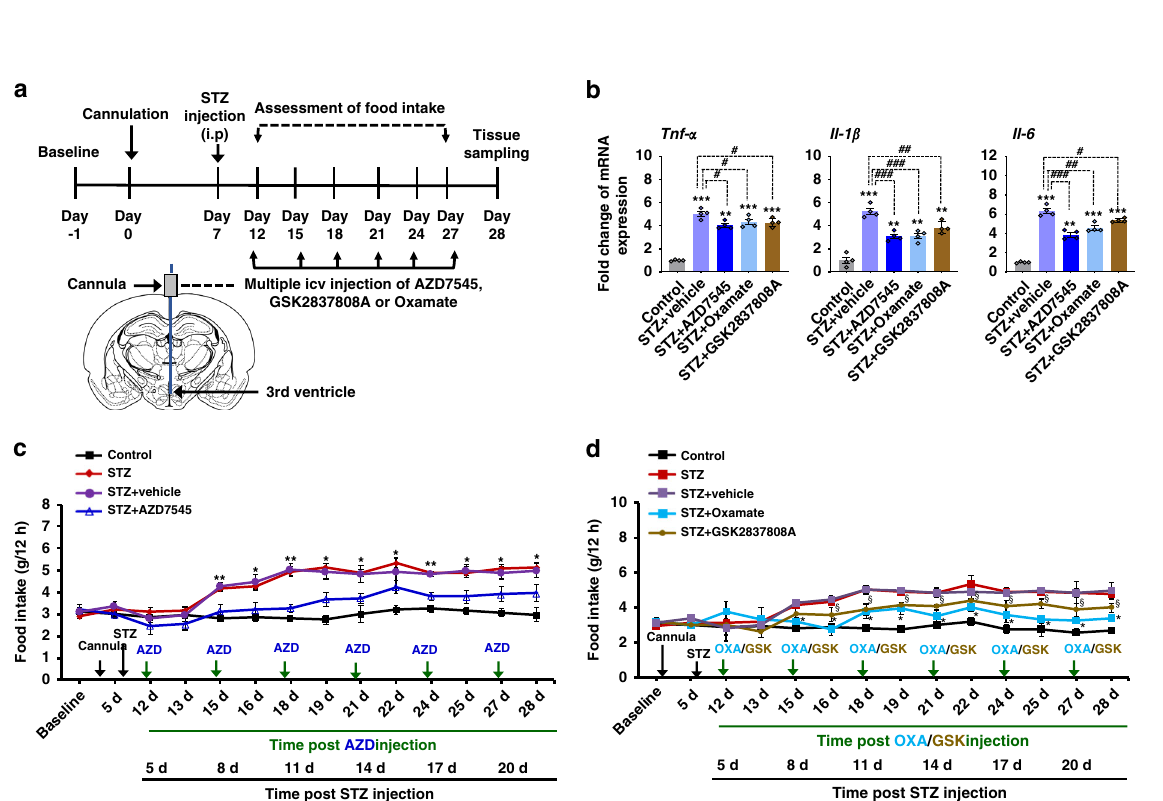
Fig. 5 Pharmacological inhibition of PDK2 and lactate production in the mouse hypothalamus attenuates diabetes-induced in fl ammatory cytokines and food intake. To determine the role of hypothalamic PDK2 or lactic acid in the regulation of food intake, we administered AZD7545 (6.4 nM of CSF concentration), GSK2837808A (2 μ M of CSF concentration), or oxamate (25 μ g) by multiple icv injections into mice starting from 5 d post-STZ injection